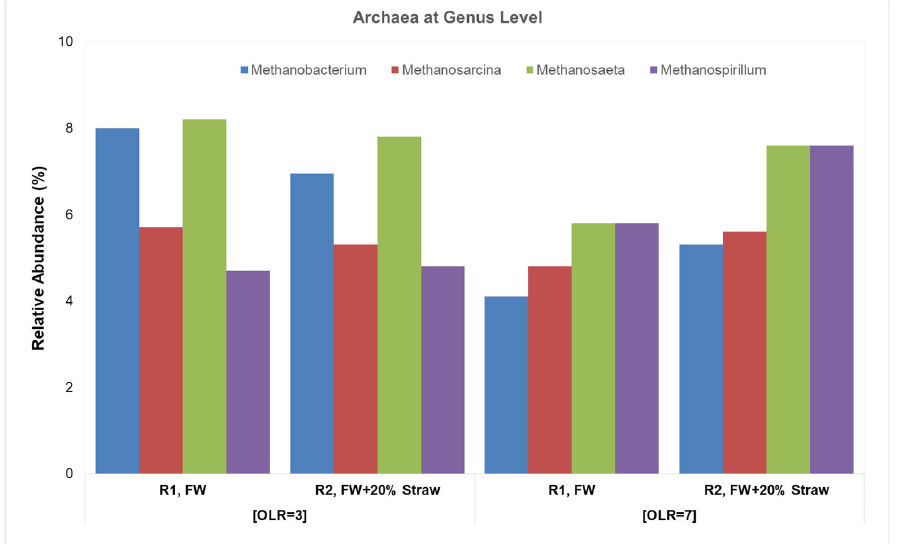
Figure 4. Relative abundance of archaeal communities at genus level at the end of Period 2 and Period 3 (target OLRs from FW were 3.0 and 7.0 gVS/L/d, respectively). Among them, Methanosarcina sp. are able to use both the acetoclastic and the hydrogenotrophic methanogenesis pathways. Demirel and Scherer [50] reported that Methanosaeta concilii was found to be the dominant acetotrophic methanogen in the